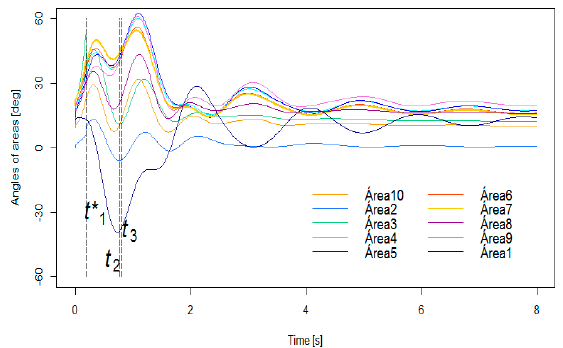
Figure 9. Voltage angles at buses when a fault occurs at 0.19 s in Line 4-5 and some control actions are applied.